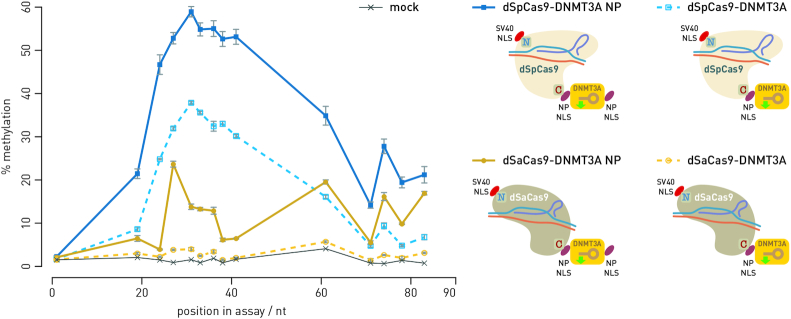
Nuclear localization signal (NLS) is critical for activity of an effector domain fused to C-terminus of dCas9. An additional nucleoplasmin NP-NLS appended to the C-terminus of the catalytic domain of DNMT3A clearly showed an increase in activity of the dCas9 fusion (solid lines) compared to activity obtained using the dCas9 fusions without additional NP-NLS (dotted lines). Each data point represents one of the 14 CpG sites analyzed for methylation level in the BACH2-A2 assay.